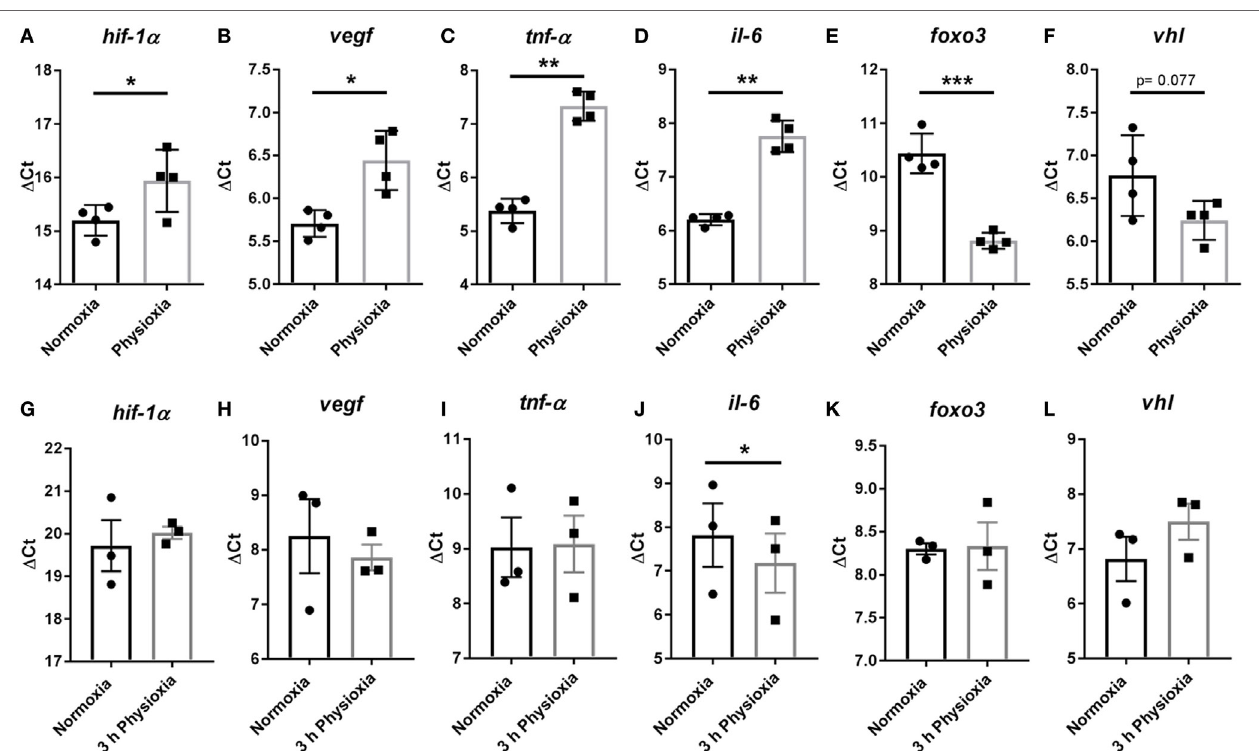
FiGUre 3 | (a–d) Transcript expression of hif-1 α , vegf , tnf- α , and il-6 in MCs differentiated under physioxia compared to normoxia. MCs differentiated under physioxia display a significant lower transcript expression of hif-1 α , tnf- α , il-6 , and vegf compared to normoxia. Transcript expression of (e) foxo3 and (F) vhl in MCs demonstrate that foxo3 is significantly upregulated by comparing physioxic versus normoxic differentiated MCs. The expression of vhl shows a tendency ( p = 0.077) to be upregulated under physioxia compared to normoxia. Depicted are the mean values and SDs of n = 4 experiments with cells derived from four mice (not pooled). (G–L) Transcript expression of hif-1 α , vegf , tnf- α , il-6 , foxo3 , and vhl in MCs of normoxic differentiated cells and a following short-term (3 h) stimulation under physioxia compared to normoxia. No difference in Δ Ct values of hif-1 α , tnf- α , vegf , foxo3 , and vhl was observable. Expression of il-6 was significantly increased under physioxia compared to normoxia. Physioxia and normoxia values were normalized to the housekeeping gene rps9 using the Δ Ct method: Ct (cycle threshold) is defined as the number of cycles required for the fluorescent signal to cross the threshold. Ct levels are inversely proportional to the amount of target nucleic acid in the sample (i.e., the higher the Ct level the lower the amount of target nucleic acid in the sample). Depicted are the mean values and SDs of n = 3 experiments with cells derived from six mice (two mice pooled for each batch). Statistical differences were analyzed using a paired, two-tailed Student’s t